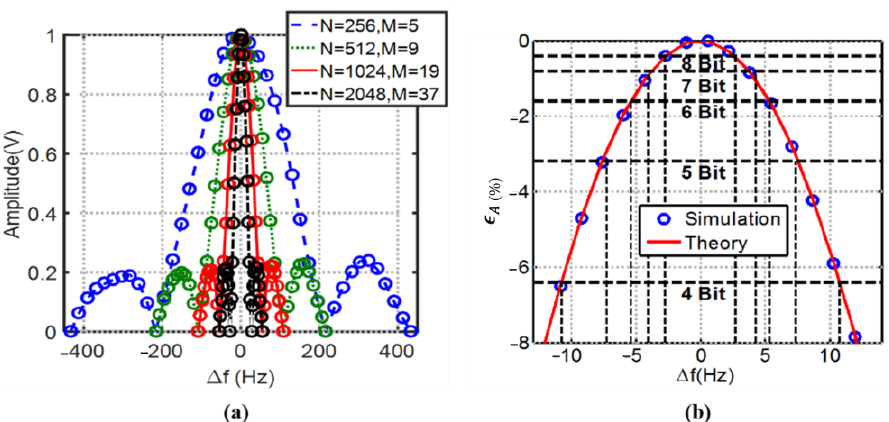
Figure 9. 3PSF ( a ) amplitude estimation for a various number of samples within a record ( b ) zoomed-in Mean amplitude percent error for N = 1024, M = 19, and normalized percent detection resolutions vs. source frequency deviation. The plots also validate that the theoretical derivations for the non-coherency effect follow the numerical simulations accordingly.